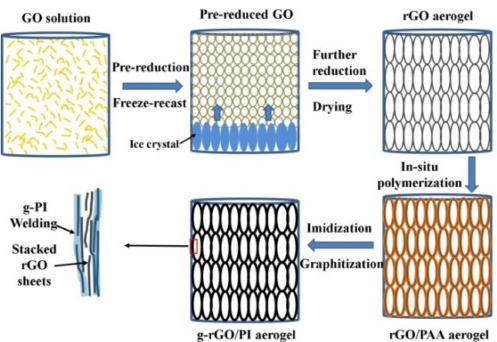
Figure 2. Illustration of the formation of graphitized reduced graphene oxide (g-rGO)/polyimide (PI)